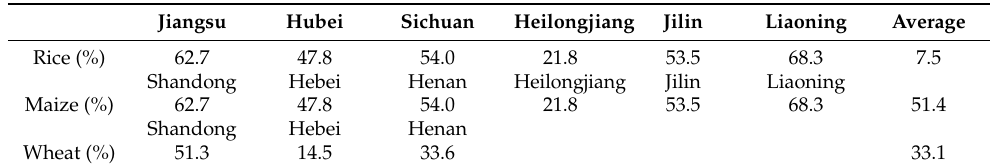
Table 1. Proportion of farm holders applying one-time nitrogen fertilizer for grain production in the major provinces in